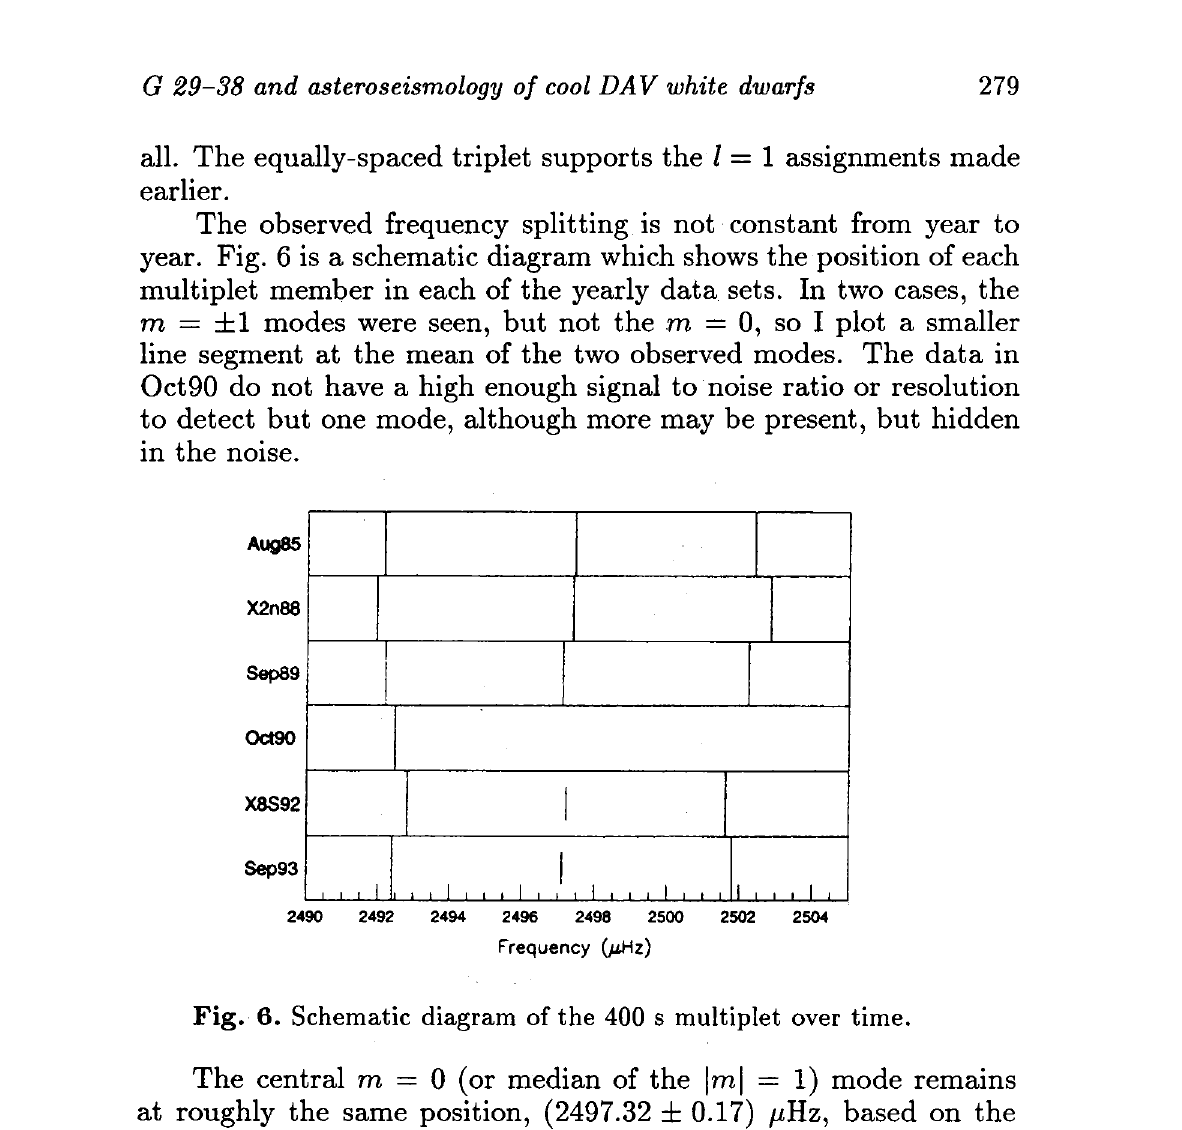
Fig. 6. Schematic diagram of the 400 s multiplet over